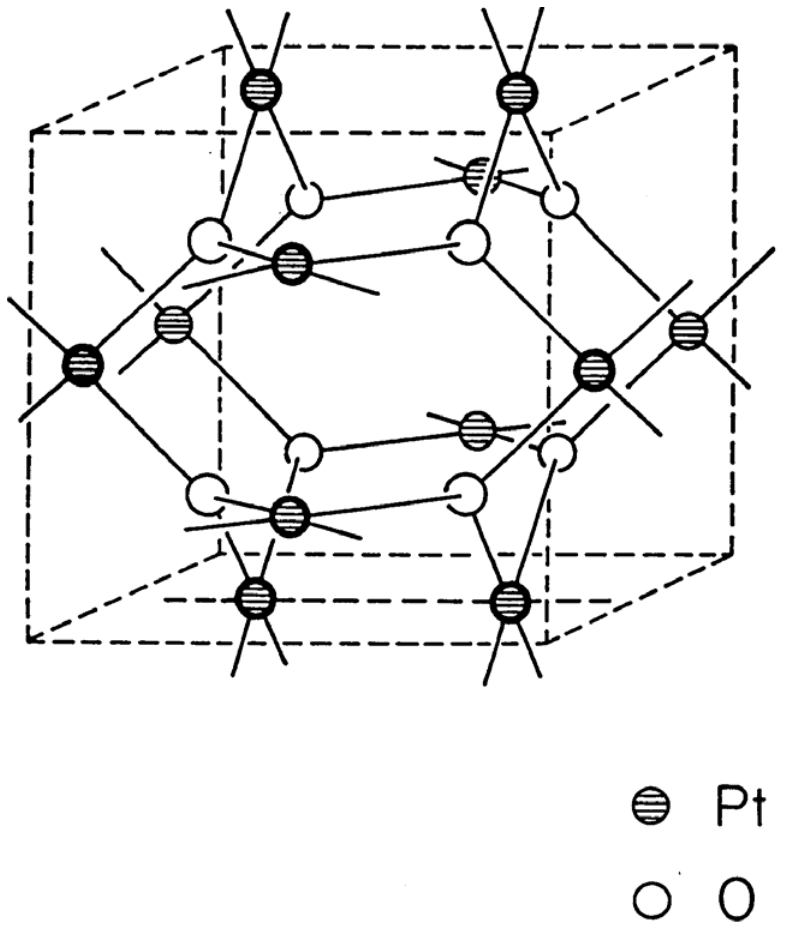
Figure 1. Waserite